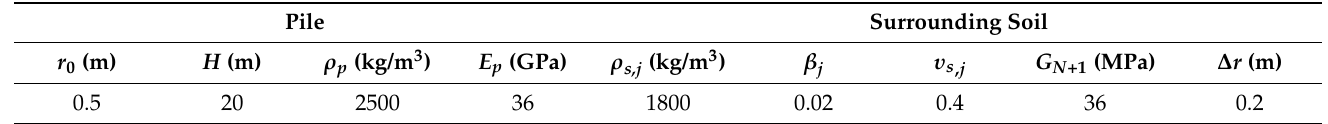
Figure 2. The effect of N on the kinematic response of piles. Table 1. Available parameters used in the